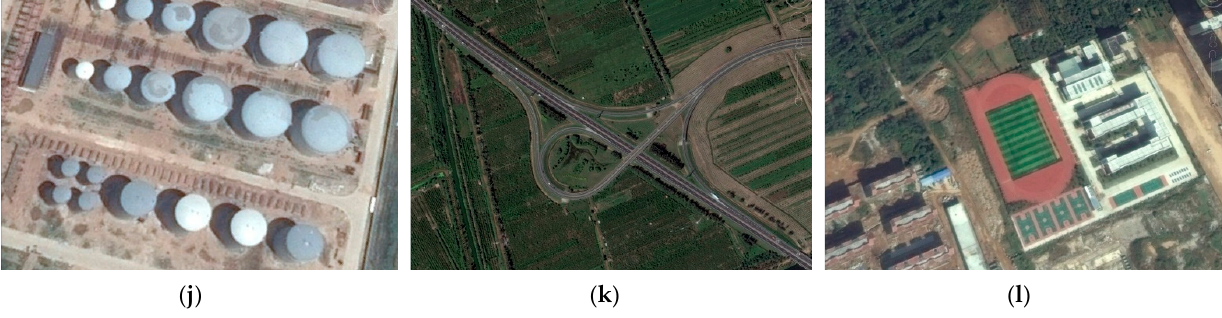
Figure 6. Examples corresponding to each category of two datasets. ( a – h ) NWPU VHR-10 dataset: ( a ) airplane, ( b ) baseball diamond and ground track field, ( c ) basketball court and tennis court, ( d ) bridge, ( e ) harbor, ( f ) ship, ( g ) storage tank and ( h ) vehicle. ( i – l ) RSOD-Dataset: ( i ) aircraft, ( j ) oil tank, ( k ) overpass and ( l ) playground.